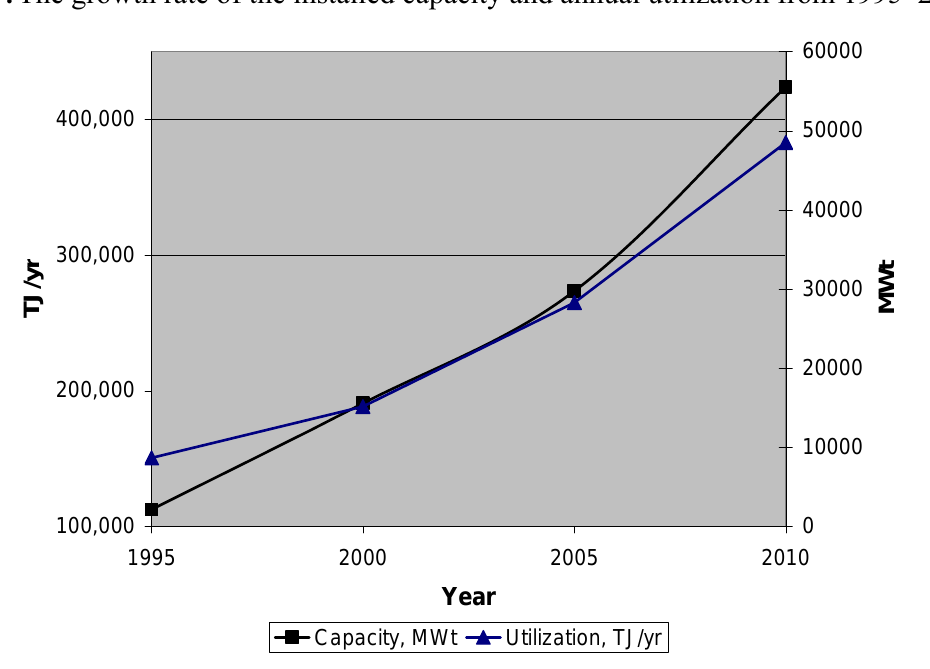
Figure 1. The growth rate of the installed capacity and annual utilization from 1995–2010